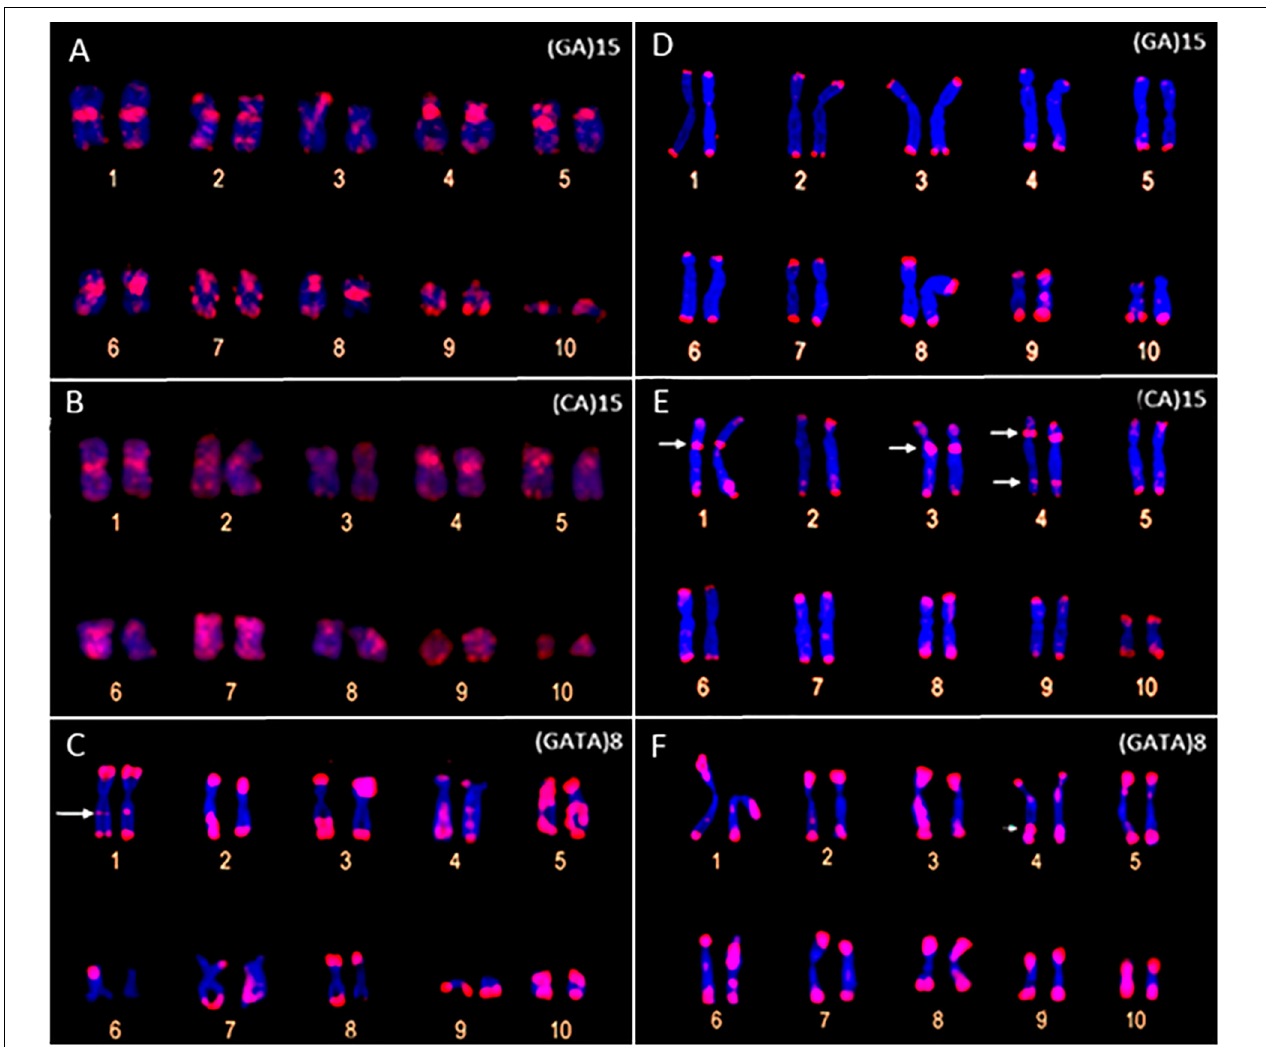
FIGURE 2 | Metaphase chromosomes of Pipa carvalhoi (A–C) and Xenopus tropicalis (D–F) submitted to fluorescent in situ hybridization with probes for the microsatellite repeat motifs (GA) 15 (A,D) , (CA) 15 (B,E) , and (GATA) 8 (C,F) . The arrows indicate the minor hybridization signals detected in the non-terminal regions of the